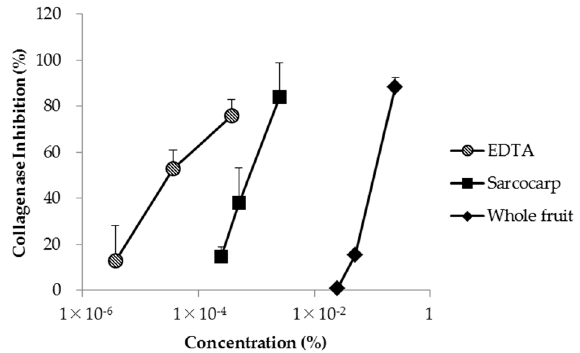
Figure 3. Collagenase inhibition effect of the aqueous extracts from C. sinensis . Equal quantities of sarcocarp and whole fruit extracts were dissolved in distilled water to the appropriate concentration, and the collagenase inhibition was determined. The sample concentration is described as the solid concentration. Results are expressed as the mean ± SD (n = 3–6).